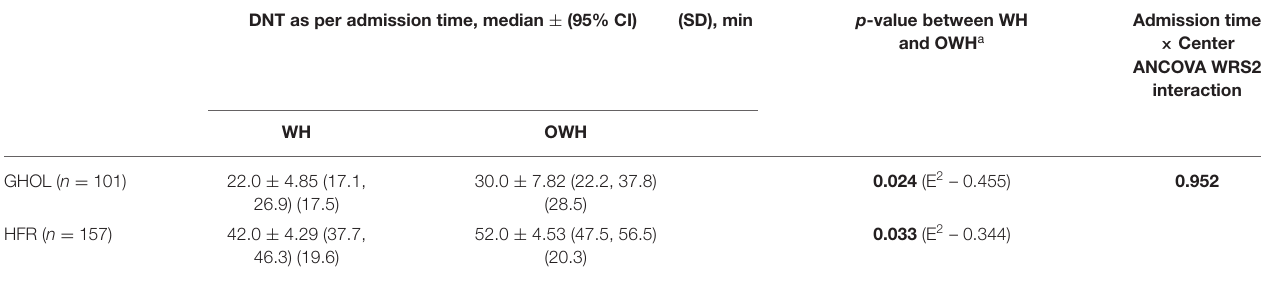
TABLE 3 | Door-to-needle time according to center (GHOL and HFR) and admission time (working hours vs. outside of working hours). DNT as per admission time, median ± (95% CI) (SD), min